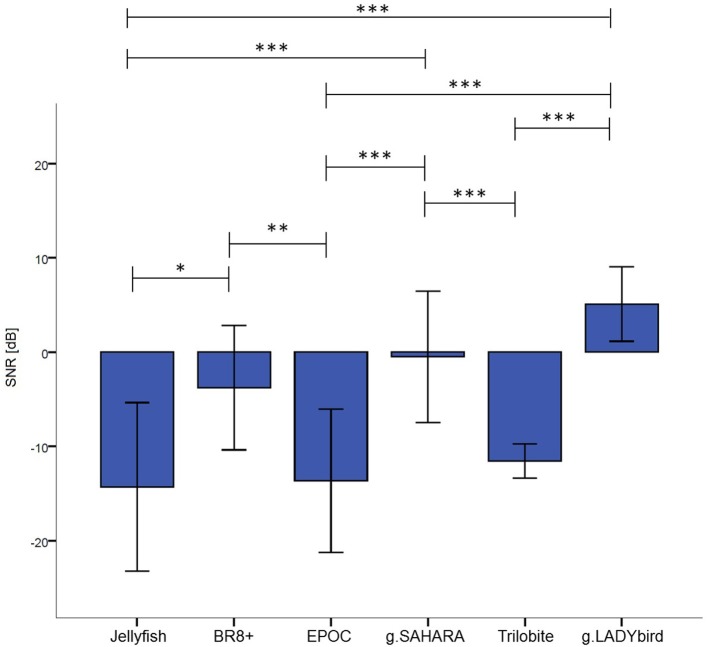
Median SNR values over channels and subjects for each device (calculation of Friedman test of differences and Bonferonni corrected post-hoc tests: ***: p ≤ 0.001; **: 0.001 < p ≤ 0.01; *: 0.01 < p ≤ 0.05; error bars indicate ± one standard deviation).